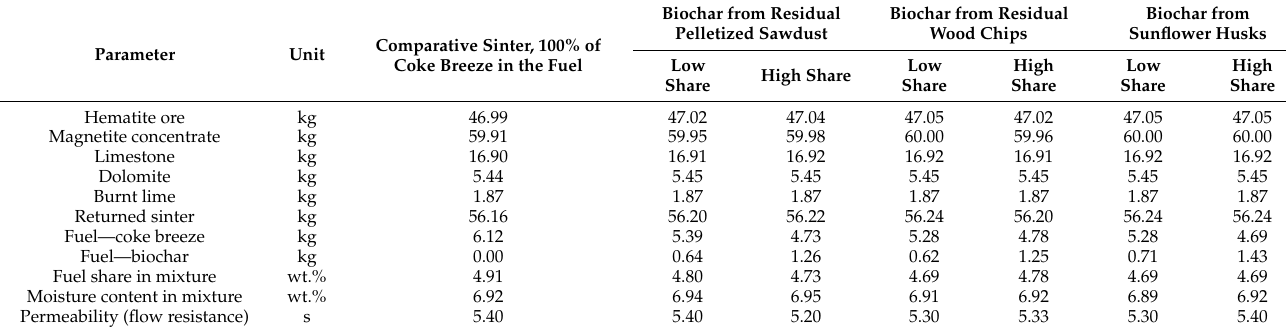
Table 3. Final properties of the sintering mixtures used in the tests.